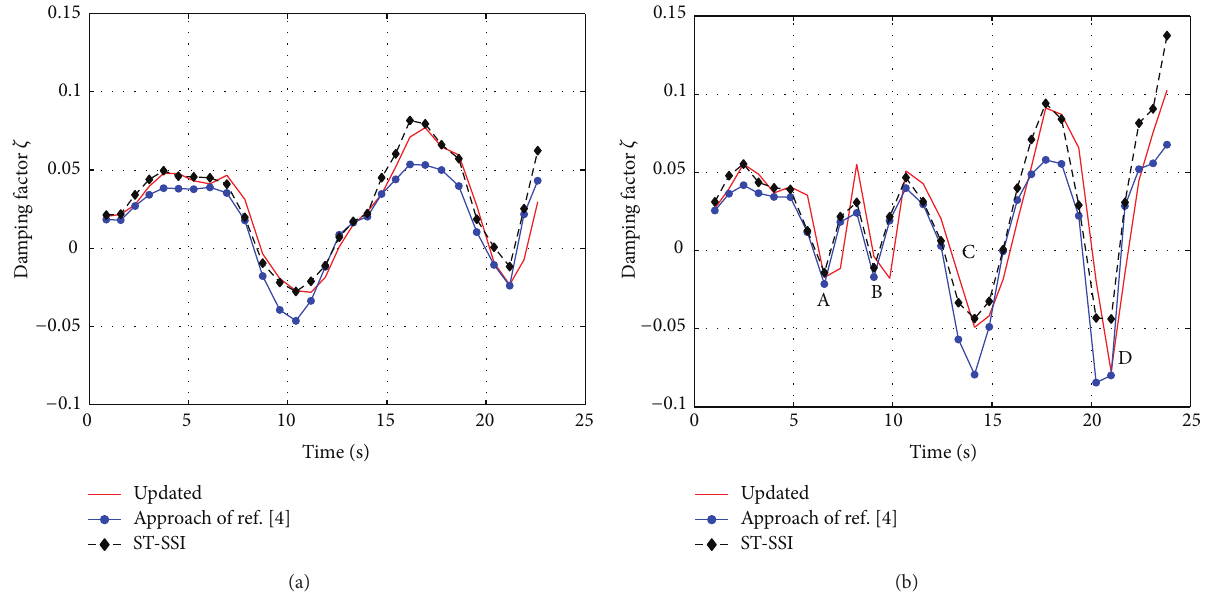
Figure 7: Estimates of the damping factors, compared with the updated value of (7). Moving-mass Case 2 (a) and Case 3